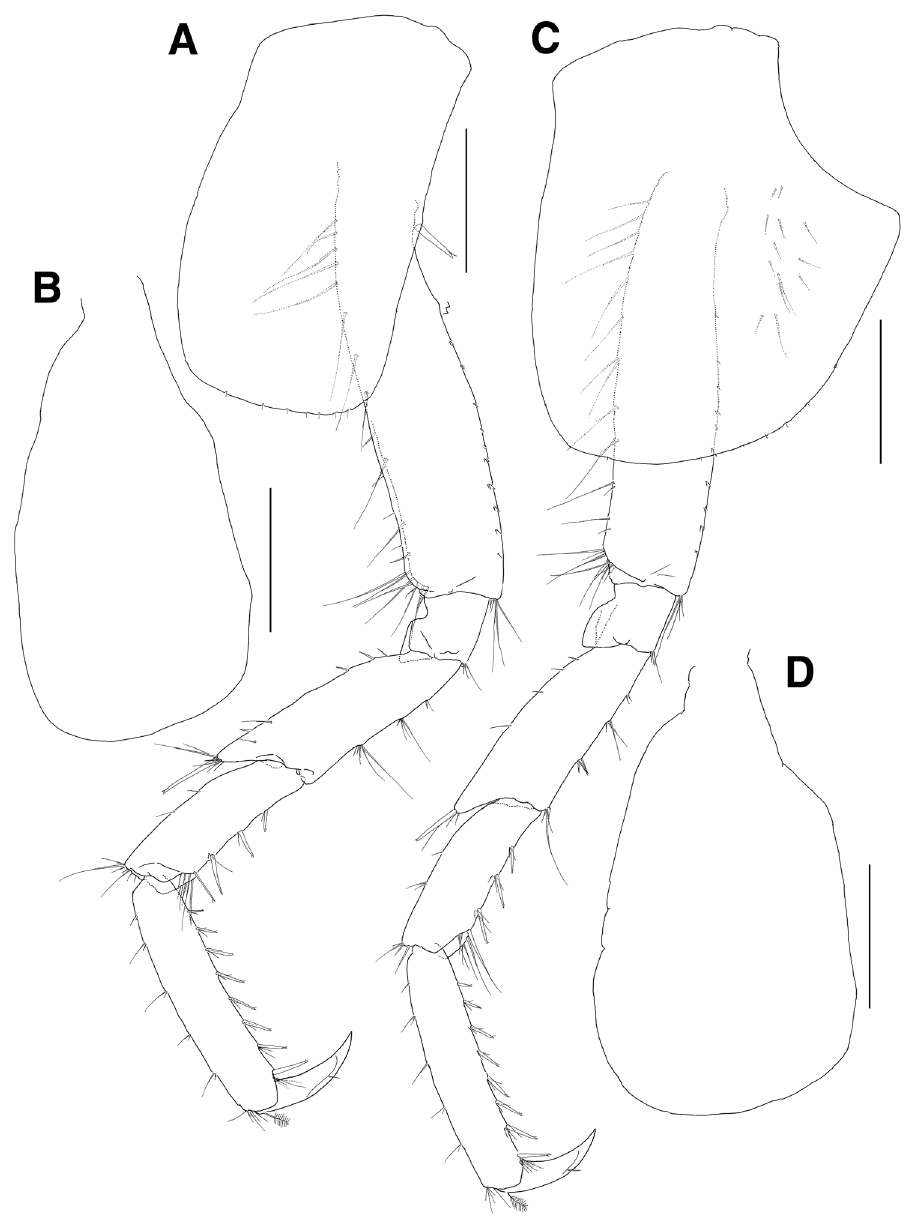
Figure 3. Eusiroides pilopalpus sp. n., holotype. A Pereopod 3 B Coxal gill on pereopod 3 C Pereopod 4 D Coxal gill of pereopod 4. Scale bars 0.5